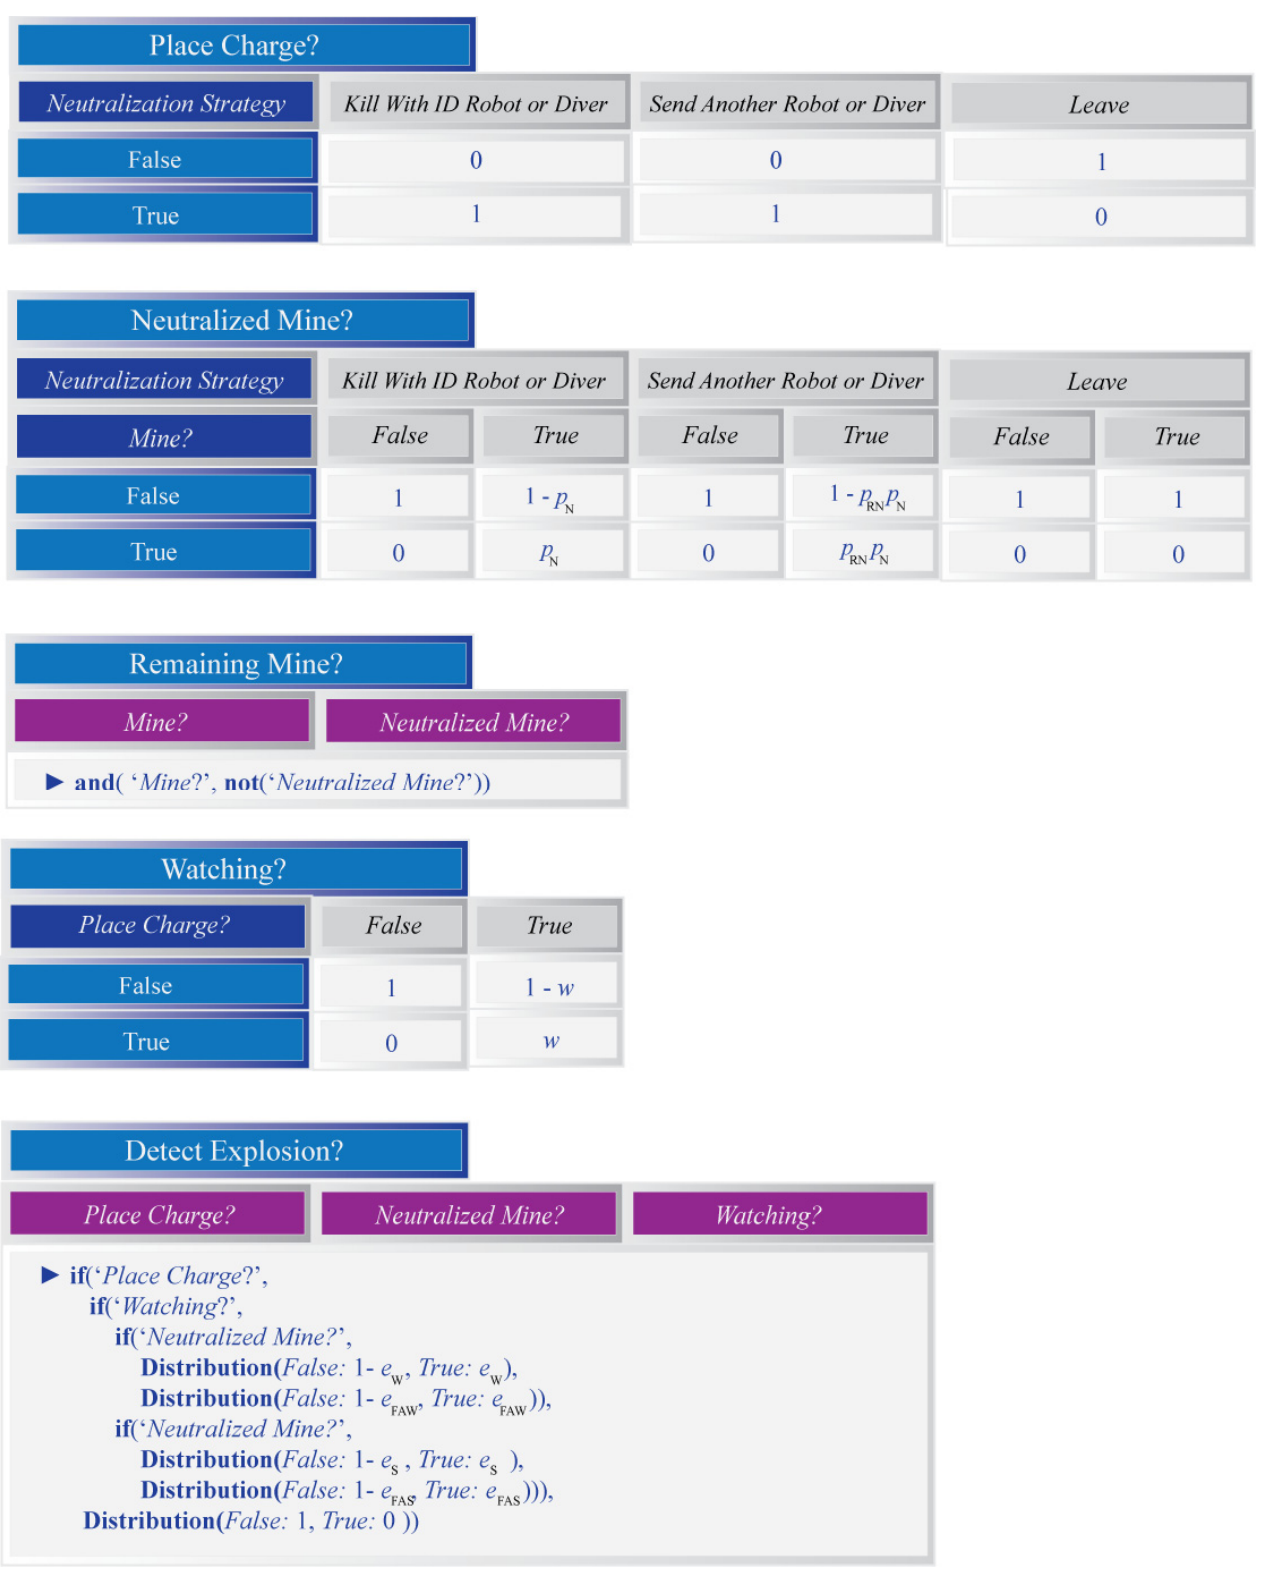
Figure A2. A selection of conditional probability tables for the Bayesian network that will be used to model inference within each grid cell. The tables for the ‘ Remaining Mine? ’ and ‘ Detect Explosion?’ variables are defined using Boolean expressions (as indicated by a triangle symbol). The if expression has three parts: a condition, a sub-expression for when the condition is True, and a second sub-expression for when the condition is False.